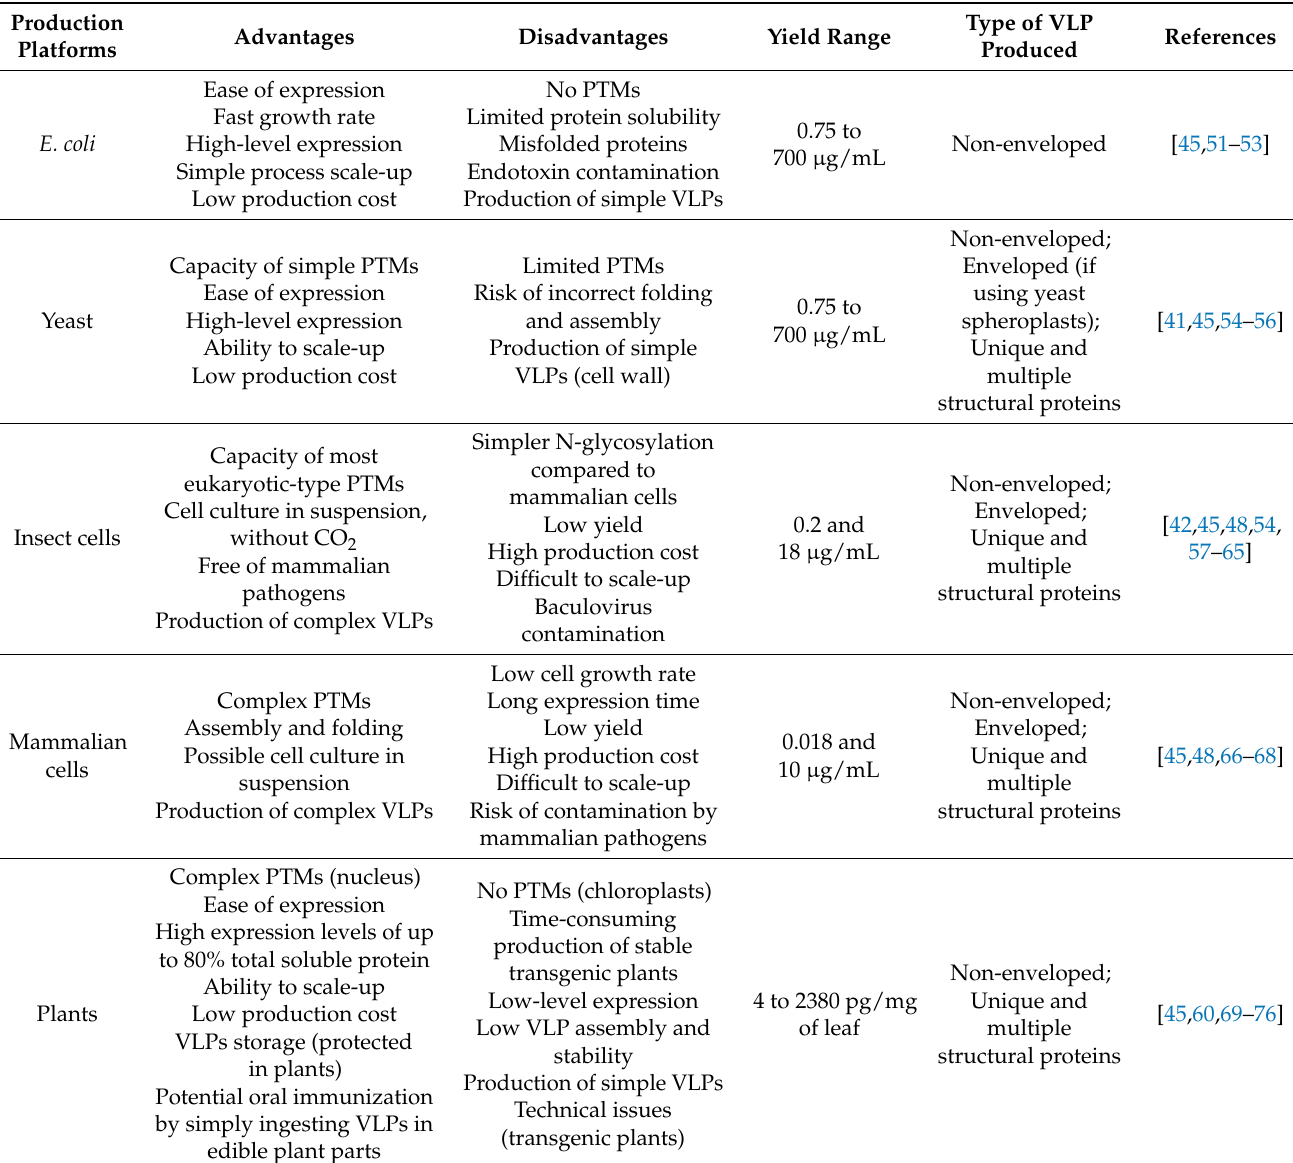
Table 1. Characteristics, advantages, and disadvantages of the different VPLs platforms